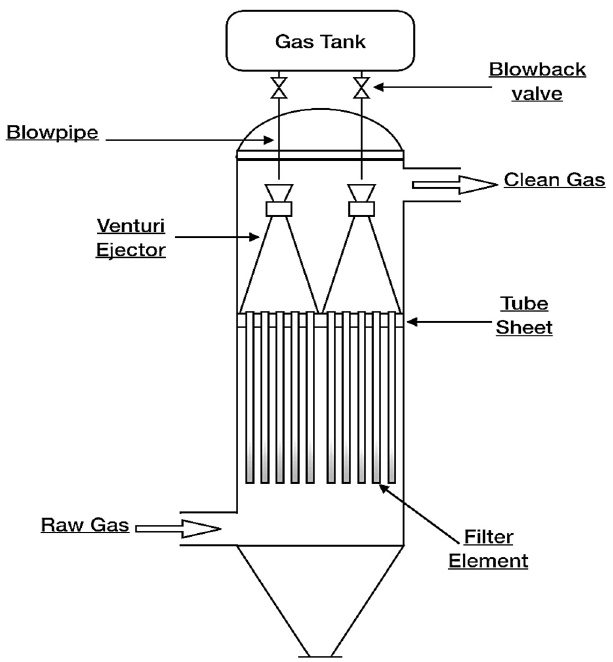
Figure 1. Scheme of a filter system with single tubesheet design (adapted from [36]).